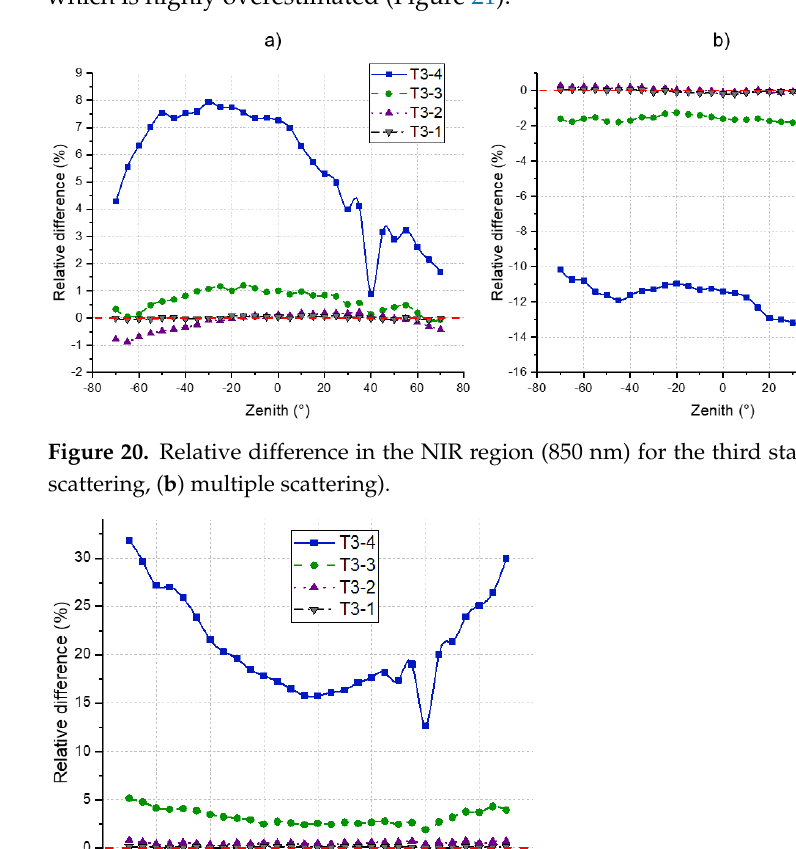
Figure 20. Relative difference in the NIR region (850 nm) for the third stage of growth ( a ) single scattering, ( b ) multiple scattering).